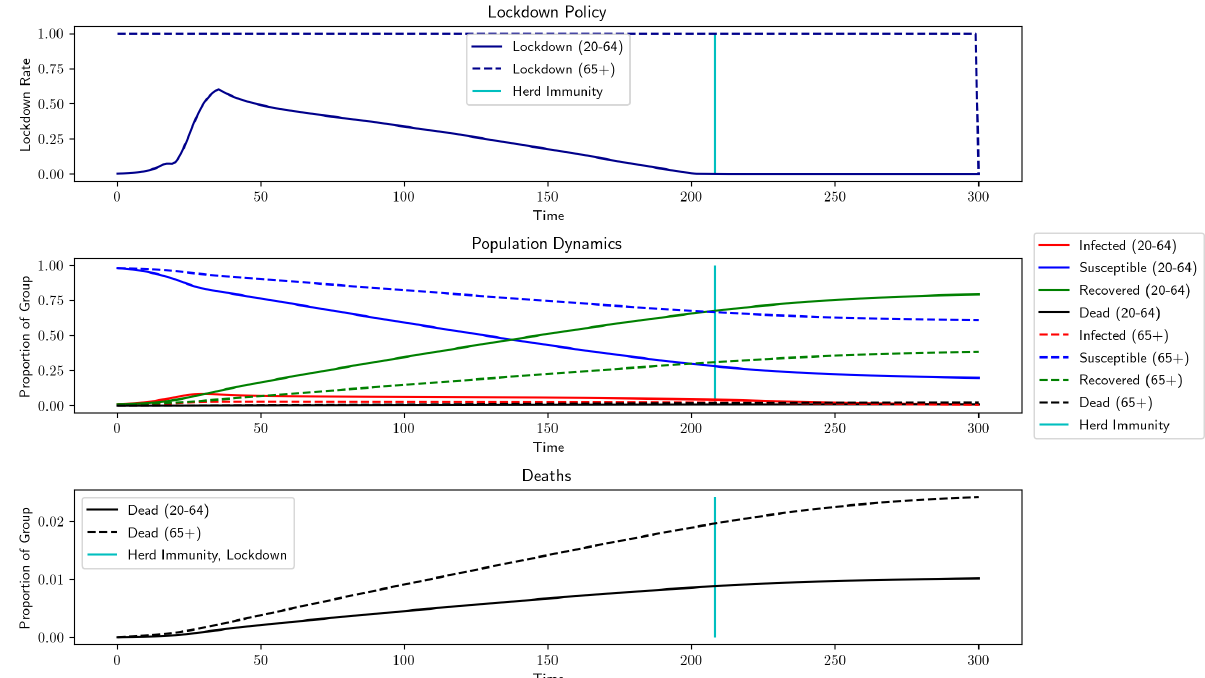
Figure 1. Our implementation of the model of [1] (no groups or herd immunity); parameters from Table A1. Output loss: 13.4232%, total deaths: 1.1754%.